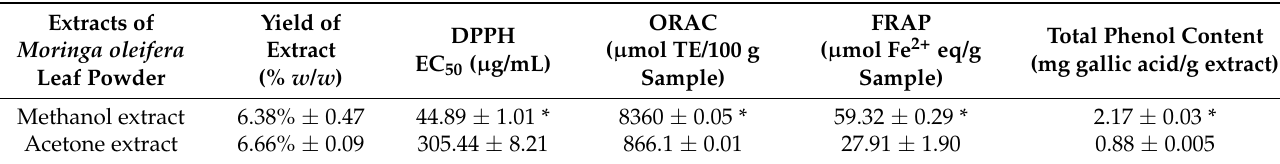
Table 2. In-vitro assays for antioxidant activity evaluation and phenolic content of methanol and acetone extracts of Moringa oleifera leaf powder. Extracts